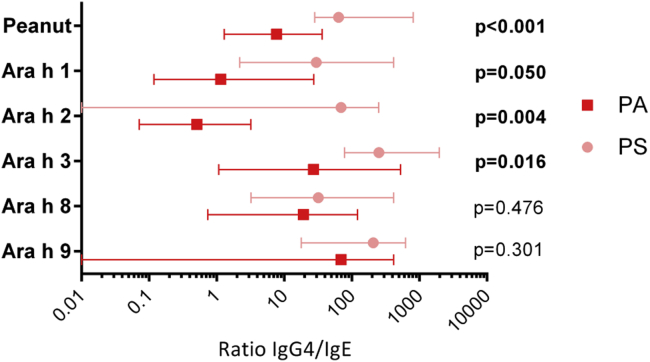
IgG4/IgE ratios to peanut and peanut allergens in children with PA (n = 65) and PS children (n = 27). Values are presented as medians and interquartile ranges. P values refer to the comparison between children with PA and PS children using the Mann-Whitney U test.